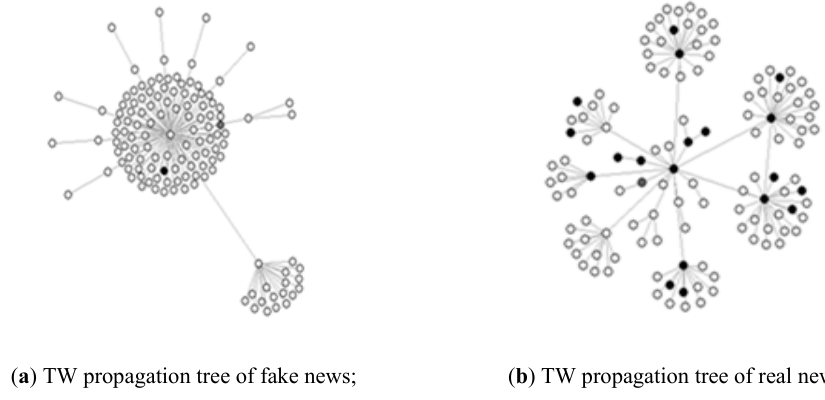
Figure 6. The TW propagation trees of fake news and real news.